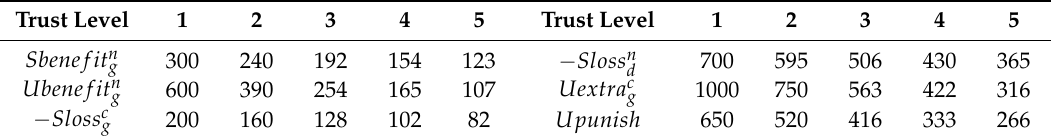
Table 4. The initial value and calculated result value.